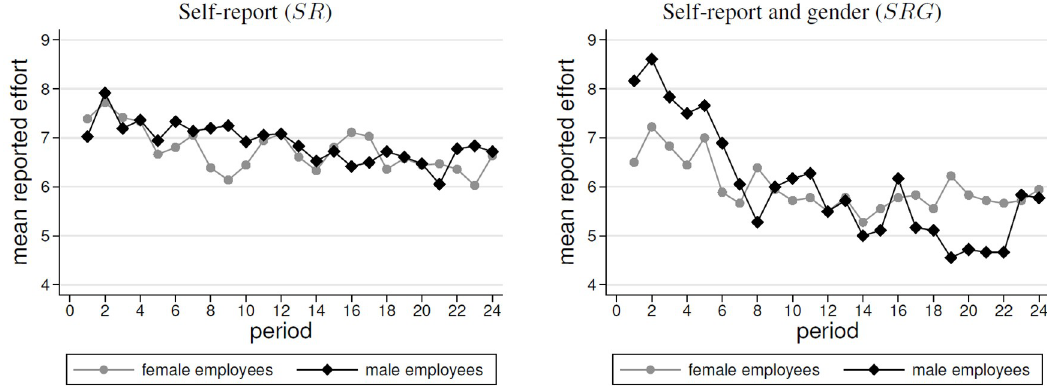
Fig 2. Average reported efforts by treatment and gender (order: SR , SRG